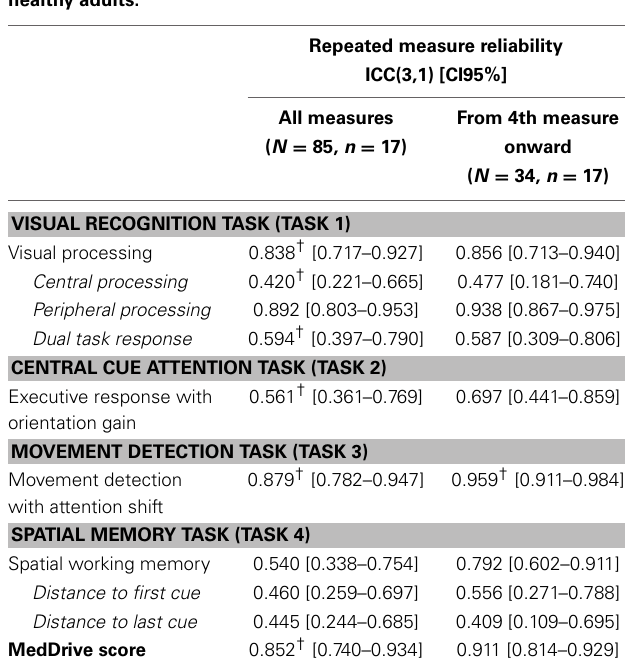
Table 5 | Reliability of measurements in research settings with healthy adults.